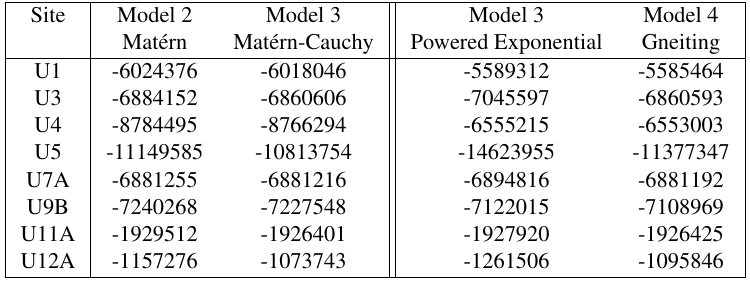
Table 2. Log-likelihood of Models 2-4